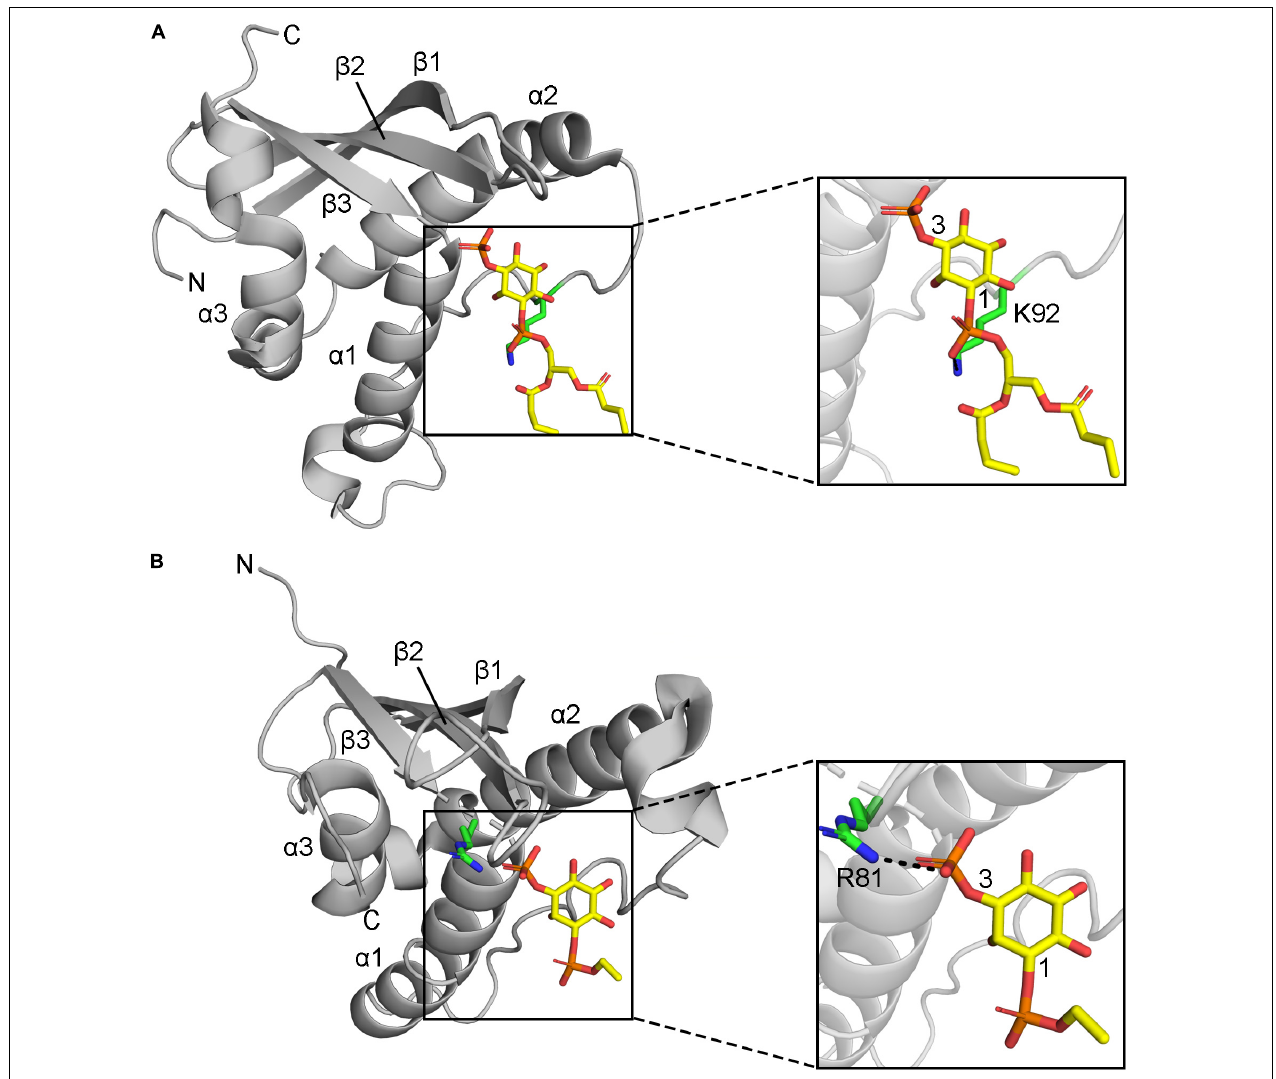
FIGURE 3 | Positions of MET-stop residues in PIP-complexed PX domain structures. (A) The p40 phox K92 sidechain in Site 3 hydrogen bonds with the 1-phosphate and is acetylated. (B) Grd19 R81 sidechain in Site 2 hydrogen bonds with the 3-phosphate in PI3P and the equivalent residue in SNX3 is